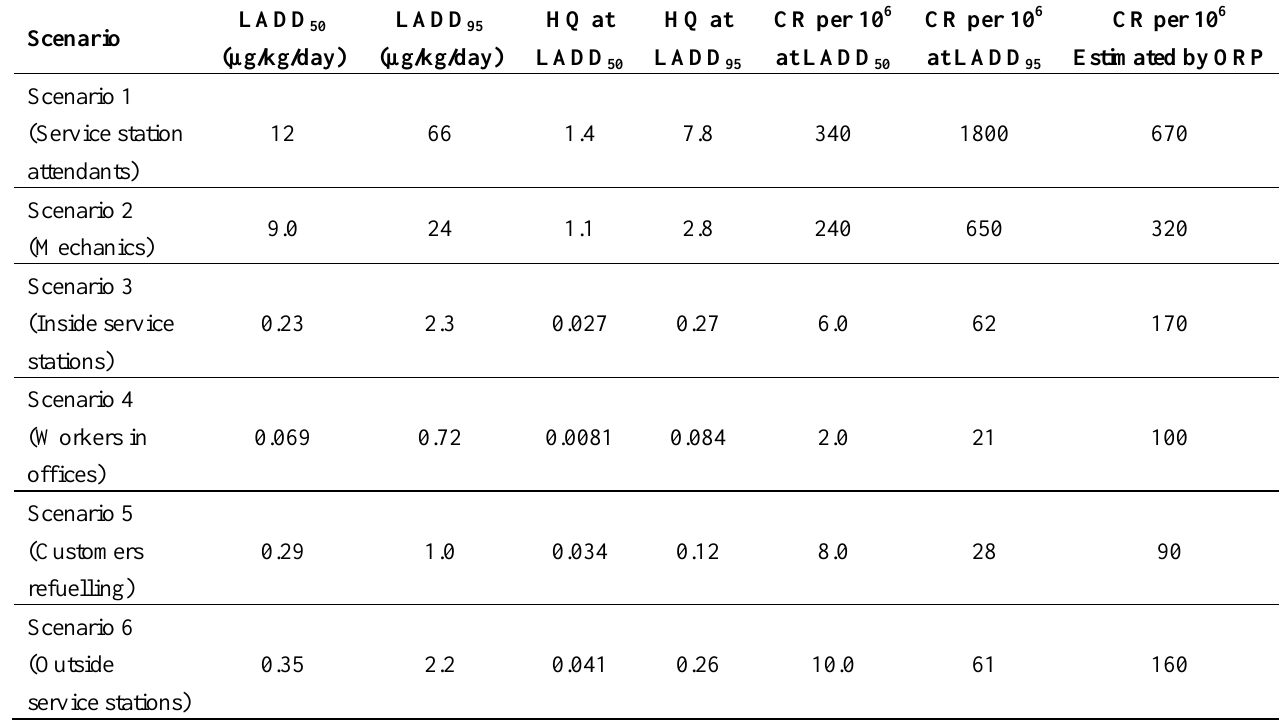
Table 5. Calculated LADD, HQ and CR per 10 6 at 50CP and 95CP for lifetime exposure to benzene concentrations in air through